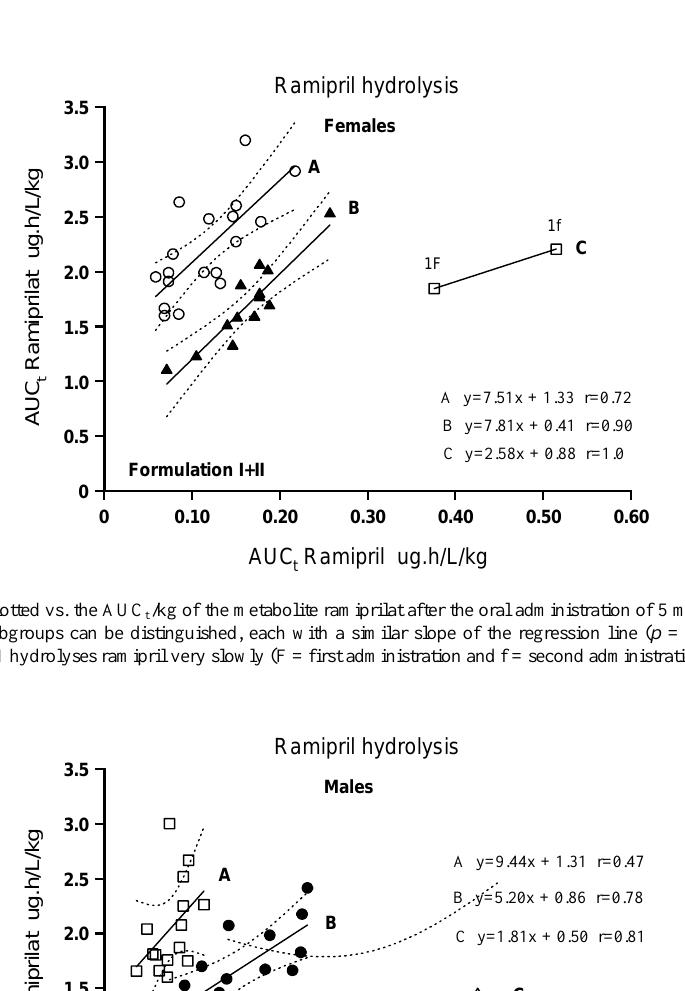
There is no male-female difference between the two highest groups of Figs. 4 and 5, concerning the slopes ( p = 0.061) and the Y-intercepts ( p = 0.85). The difference is present in the lowest group, slope (F > M, p < 0.0001) and Y-intercept (M > F, p <